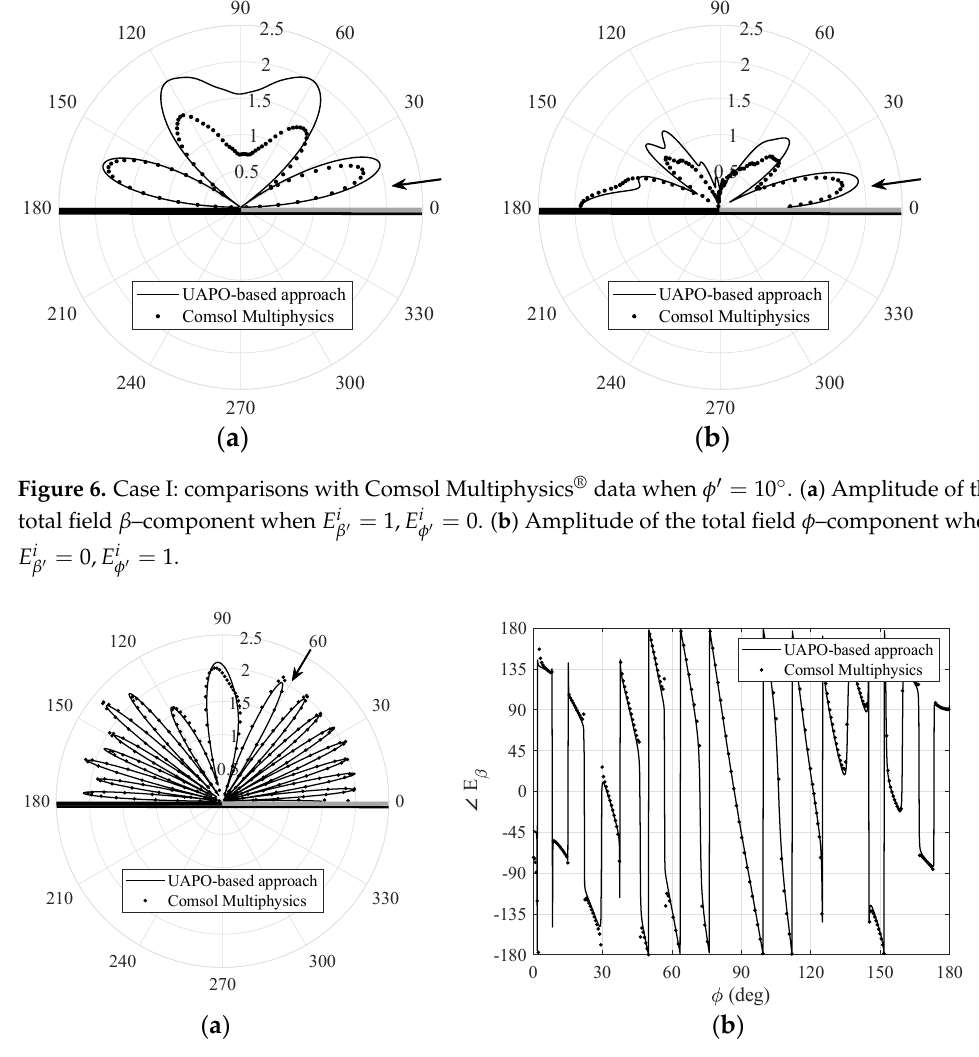
Figure 7. Case II: comparisons with Comsol Multiphysics ® data when φ (cid:48) = 60 ◦ , E i ( a ) Amplitude of the total field β –component. ( b ) Phase of the total field β –component.